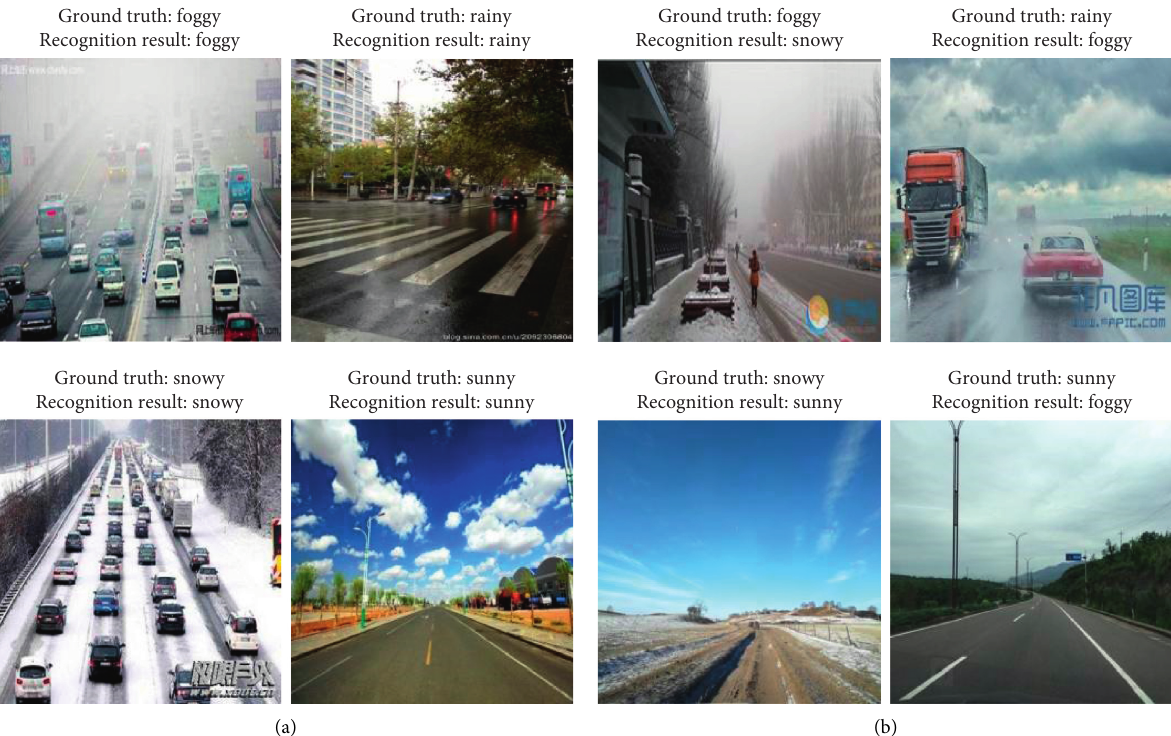
Figure 8: Examples of weather recognition results. (a) Results of correct recognition. (b) Results of wrong